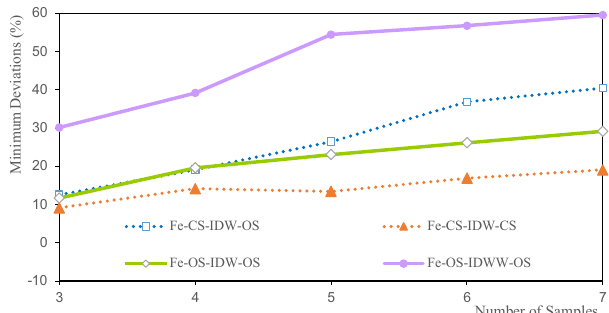
Figure 17. Deviation of the Fe minimum